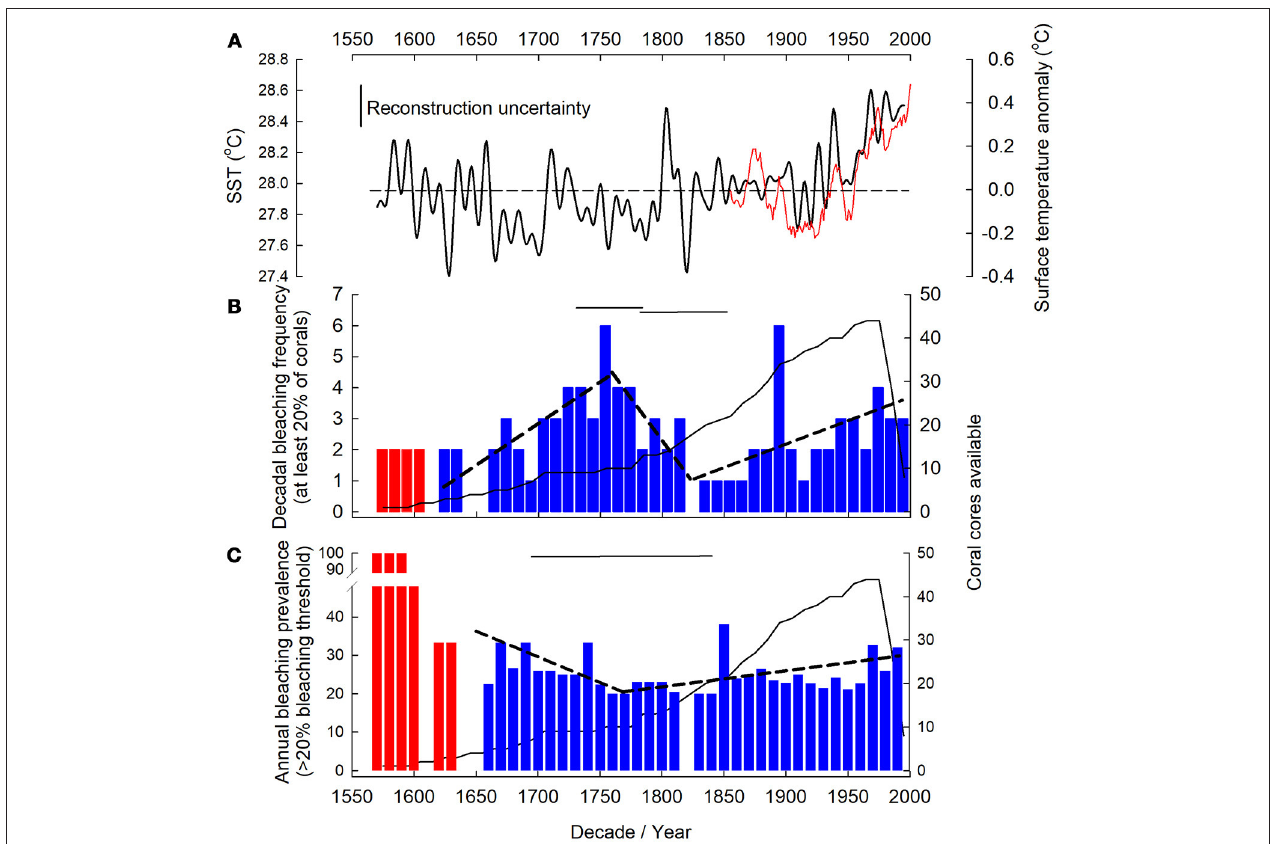
FIGURE 4 | Massive Porites spp. bleaching frequency and prevalence. NOAA extended sea surface temperature (SST) for Great Barrier Reef (GBR) (A) from ship and buoy data (1854–2000, 11 yr moving average, red line) ( Smith et al., 2008). Southern hemisphere surface temperature anomaly (ocean and land) reconstruction (Mann et al., 2008) (solid line) with the uncertainty (0.23 ◦ C) on the reconstruction indicated (the reconstruction includes coral extension rates so is not fully independent of our reconstruction). Dashed line indicates mean temperature over record length (1570–1995). Bleaching frequency (B) (number of years per decadal bin in which bleaching occurred) and prevalence (C) (% of corals bleached per decade) observed in at least 20% of coral for the GBR denoted by blue bars. Red color bars indicate years in which less than 2 (frequency)/3 (prevalence) coral cores were available; those years were excluded from further analysis (see Supplementary Material ). Number of coral cores available in each decade indicated by solid black line. Dashed black line indicates breakpoint determined linear trend in bleaching and horizontal solid black lines represent breakpoint location 95%CI. For (B) decade notation marks the start of the bin for frequency and each coral core ( n = 44) contributed up to 10 annual growth extensions per decadal